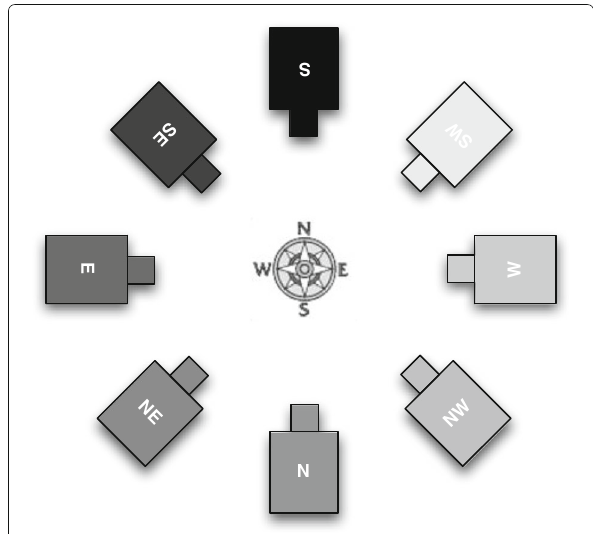
Fig. 4 Inspection gesture: Phase-locked rotation and revolution of subject for orbit around an object of regard. (Cameras arranged around the token rosette are labeled with the direction they are